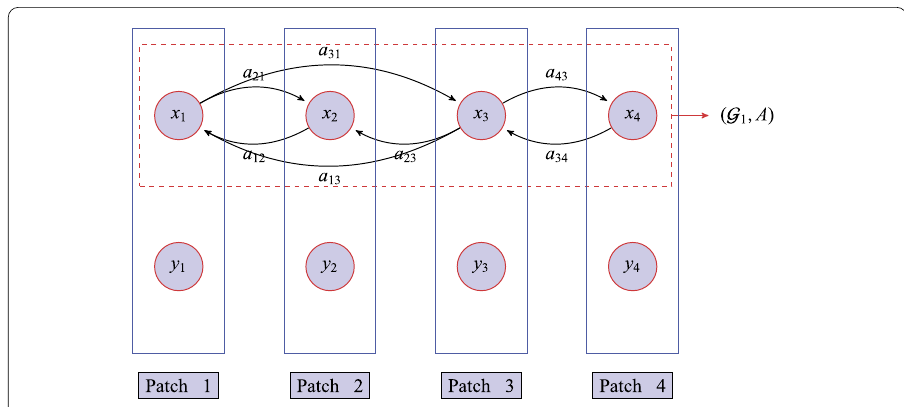
Figure 3 The solution of system (3) on four patches with time step size h = 0.001 and the dispersal networks as in Figure 1